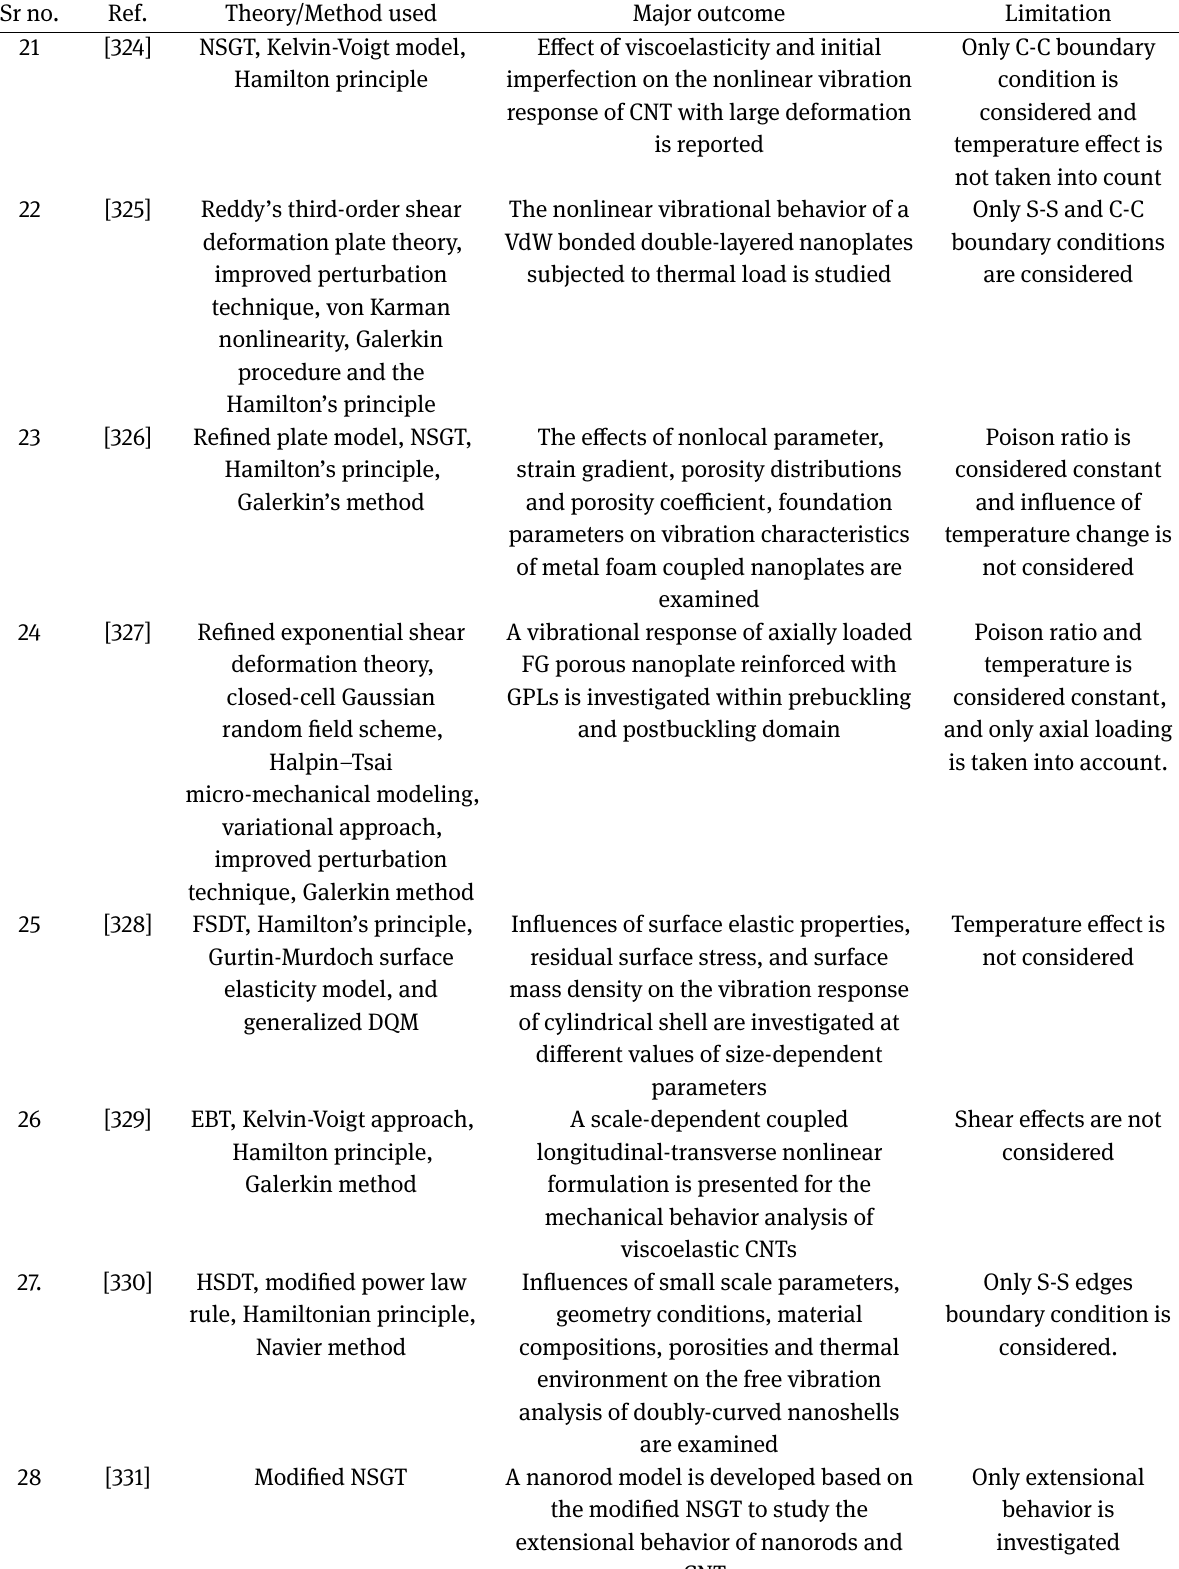
Table 4: ...continued Sr no.